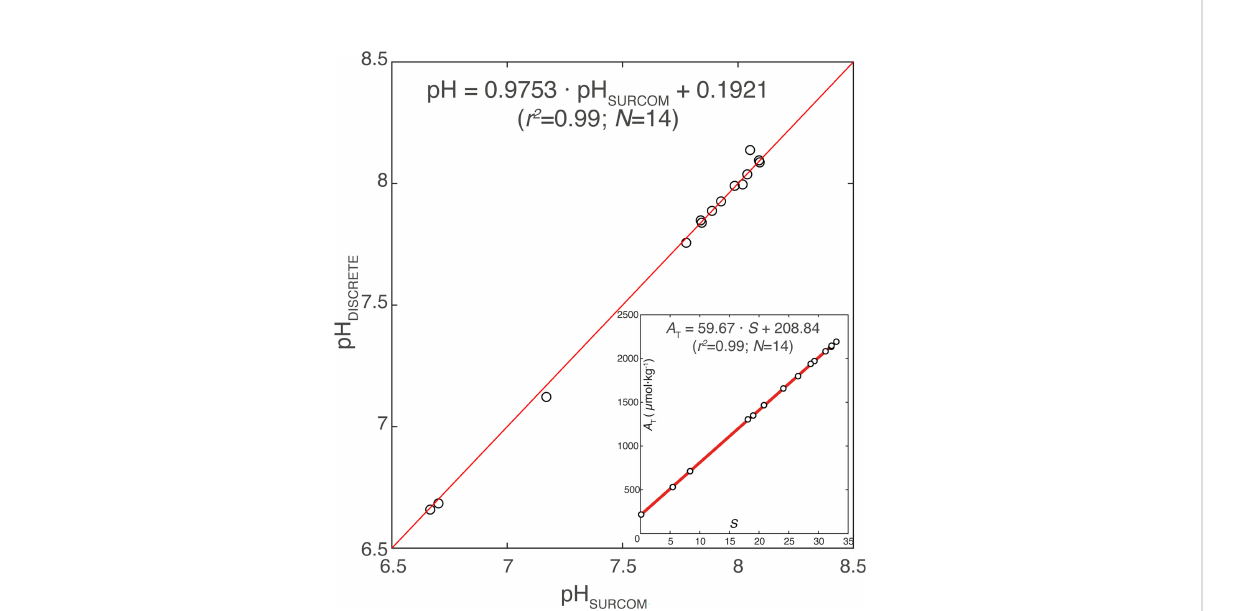
FIGURE 3 Spectrophotometric pH values from discrete samples versus calibrated pH values taken from SURCOM sensor and A T versus salinity values (inner panel) measured in discrete samples taken during the SURCOM sensor mooring. Linear regression equations, the number of samples ( N ) and the coef fi cient of determination ( r 2 ) of both x-y plots are